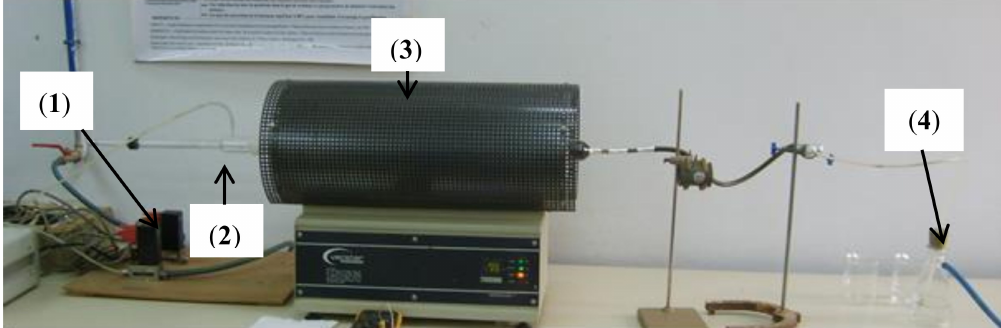
Figure 2. Experimental device for the briquettes combustion in a tubular furnace: ( 1 ) Flowmeter; ( 2 ) Quart reactor; ( 3 ) Tubular kiln; ( 4 ) Solution of 5% HNO 3